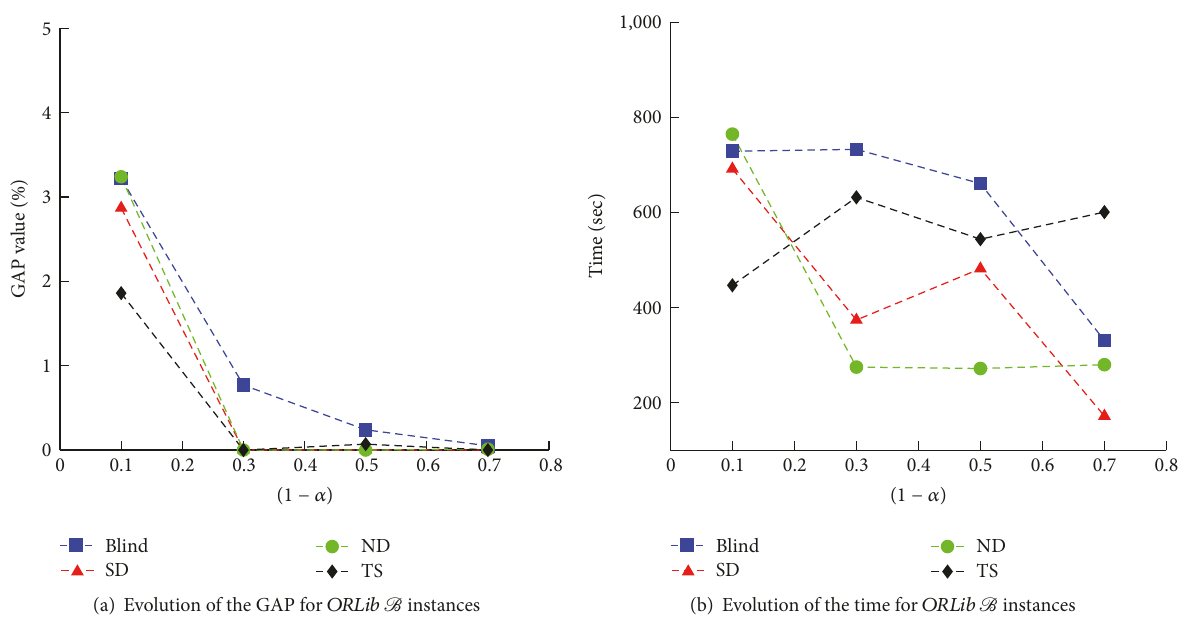
Figure 5: Average results obtained by the local search algorithms for each value of (1 − 𝛼) for 𝑂𝑅𝐿𝑖𝑏 B instances.